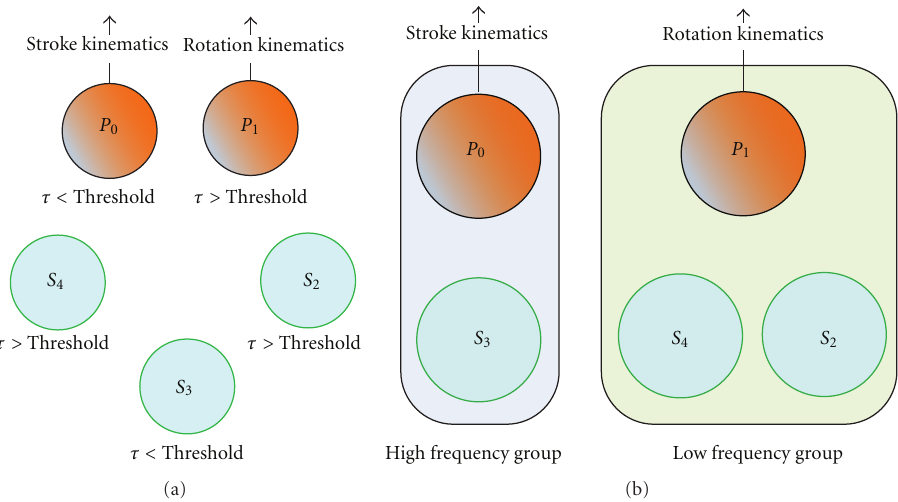
Figure 9: A pictorial representation of the “frequency-based grouping” process. The first step of the process, as shown in (a), is to determine a relative threshold time constant (Tau) for the reduced network, reduced by “dynamics-deprived neuron elimination” process, followed by grouping the neurons in the architecture based on the frequency of the output produced by individual neuron (i.e., the neurons with time constant less than the relative threshold are clustered into high frequency group, and neurons with time constants more than the relative threshold are clustered into low frequency group) as shown in (b).